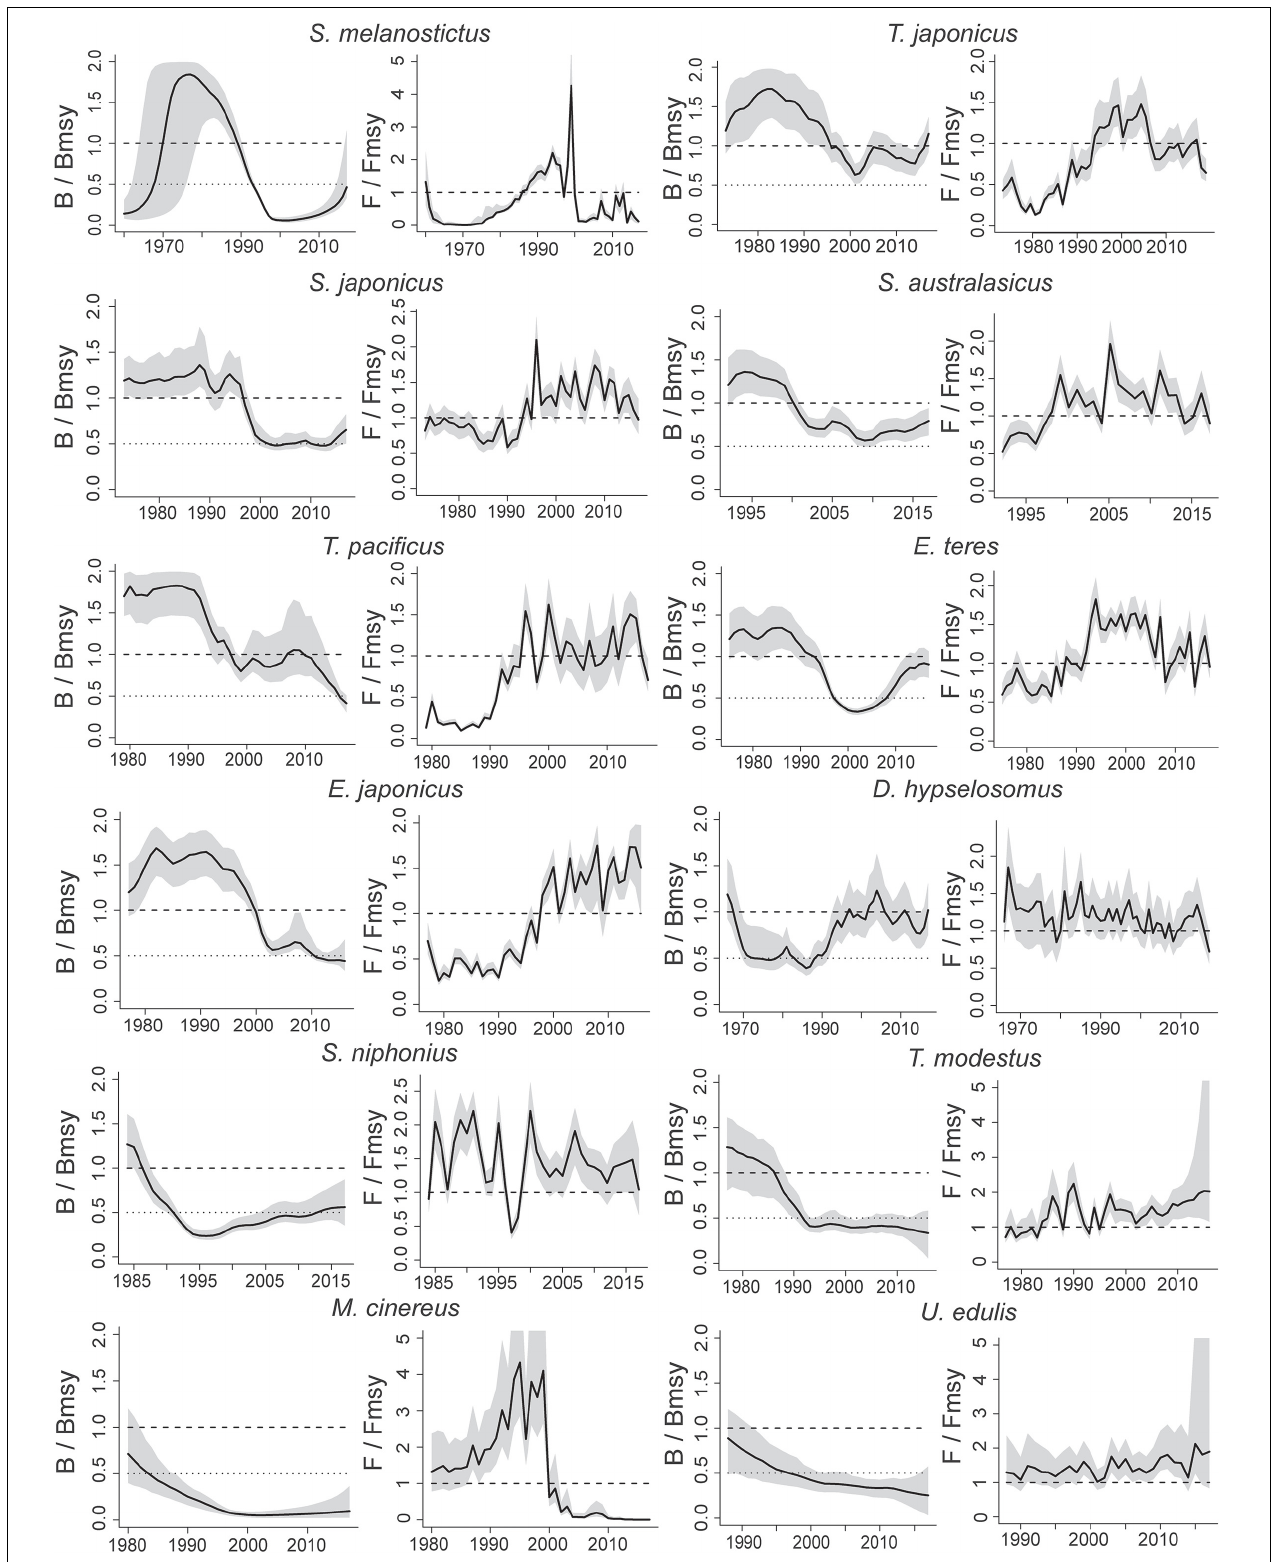
FIGURE 2 | For each stock, the left graph shows the trajectory of relative total biomass ( B/B MSY ), and the gray area indicated 95% confidence intervals; the right graph shows relative exploitation ( F/F MSY ), with F MSY corrected for reduced recruitment below 0.5 B MSY .